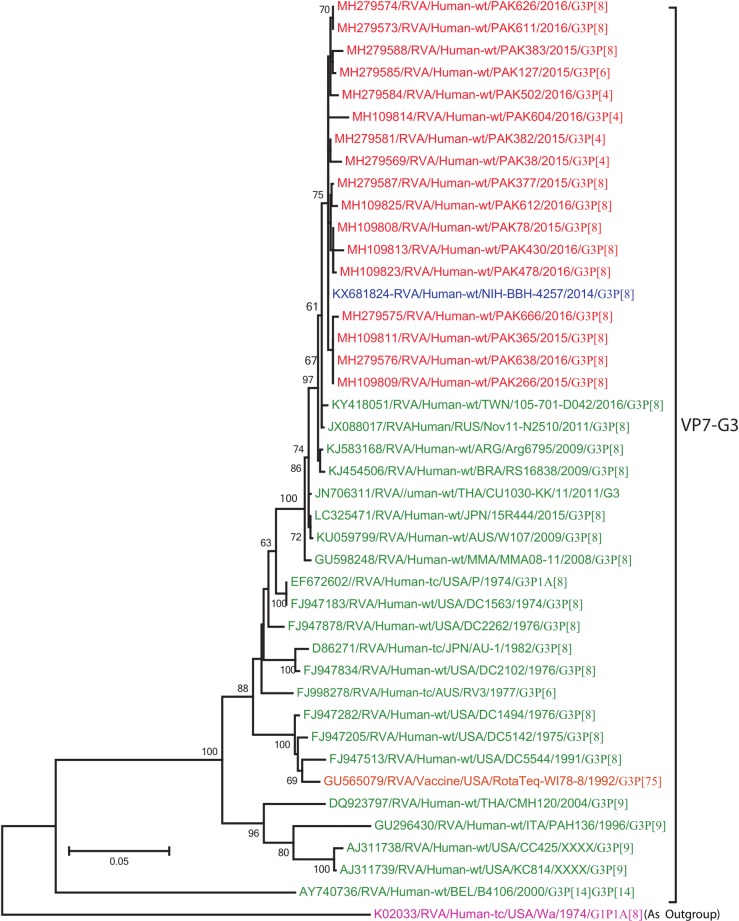
Maximum likelihood phylogenetic tree constructed from the nucleotide sequences of G3-VP7 strains and representative RVA strains with kimura-2-parameter model in MEGA program 6.0.Bootstrap values <60 are not shown. RVA strains sequenced in this study are represented by the red colour. Pakistani Strains reported in the previous studies are shown in blue. The vaccine strains and an out group strain are represented by purple and orange colour respectively while green shading represent strains isolated in all over the world. The RVA strains sequenced in this study and reference strains obtained from GenBank database are represented by Accession number, Strain Name, Country and year of Isolation. Scale bar: 0.05 substitutions per nucleotide.